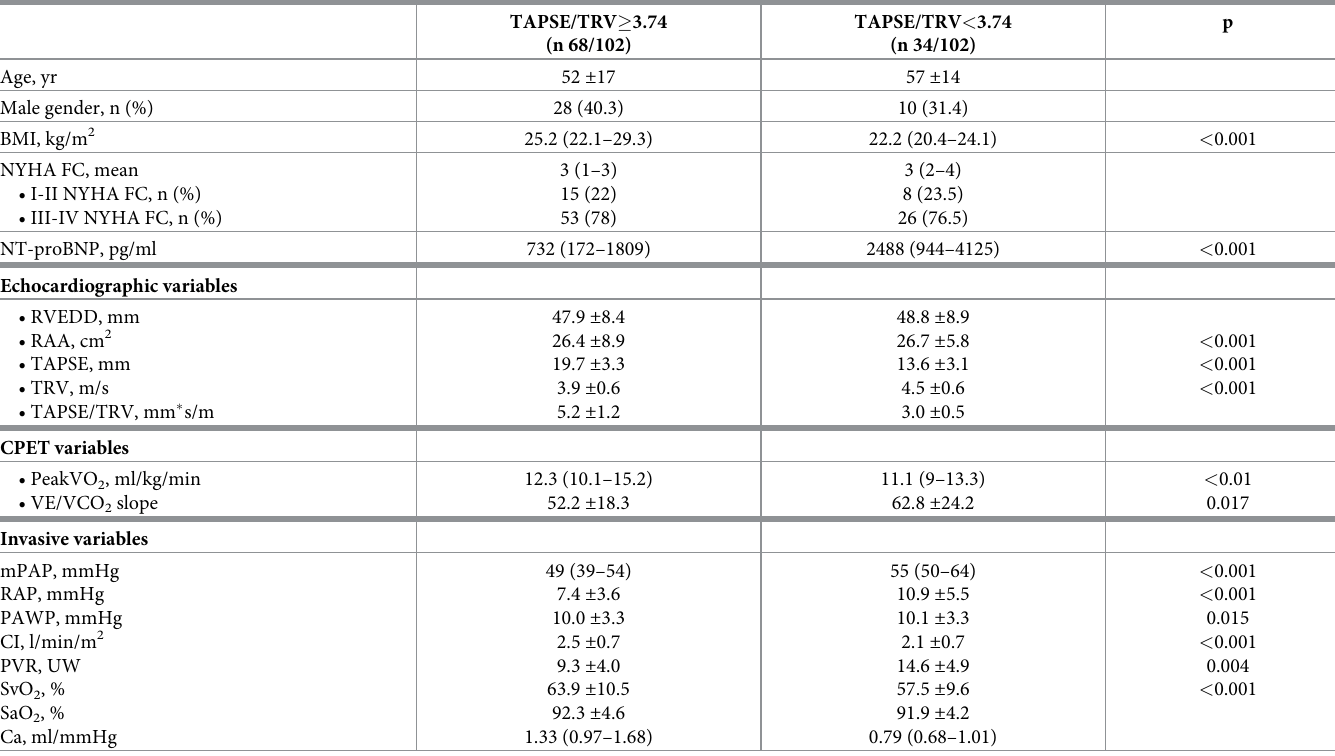
Table 4. Characteristics of the population according to TAPSE/TRV ratio